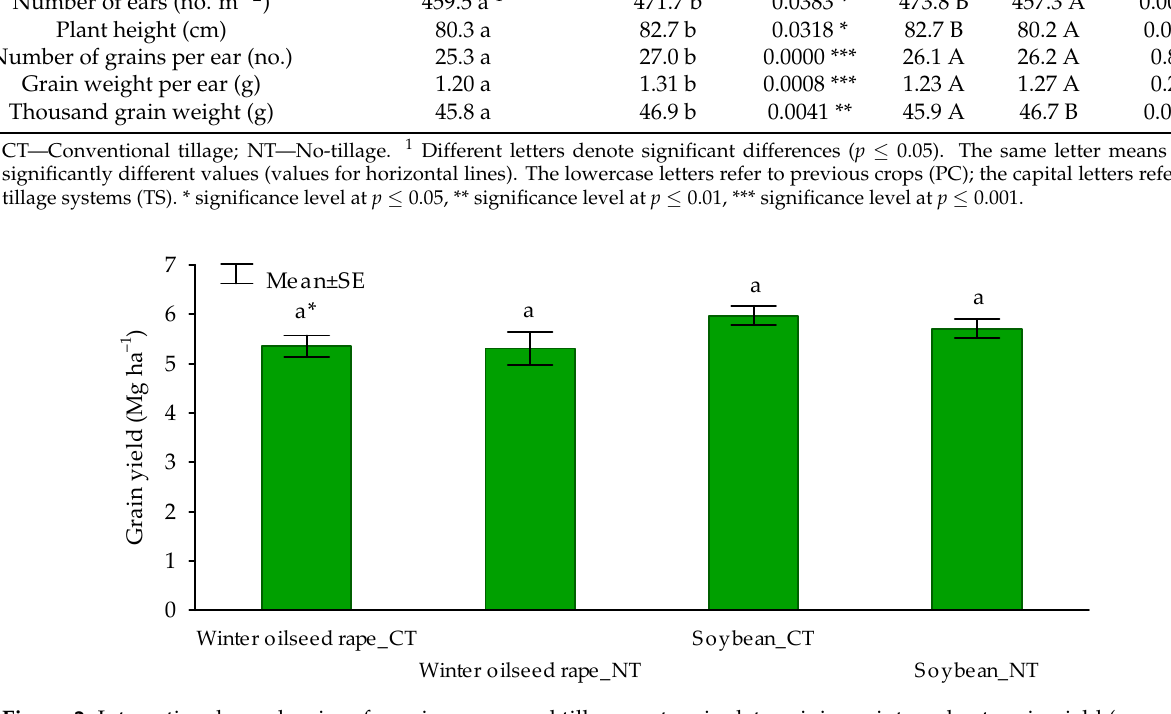
2014–2017). CT—Conventional tillage; NT—No-tillage. * The same letter means not significantly different values ( p ≤ 0.05).